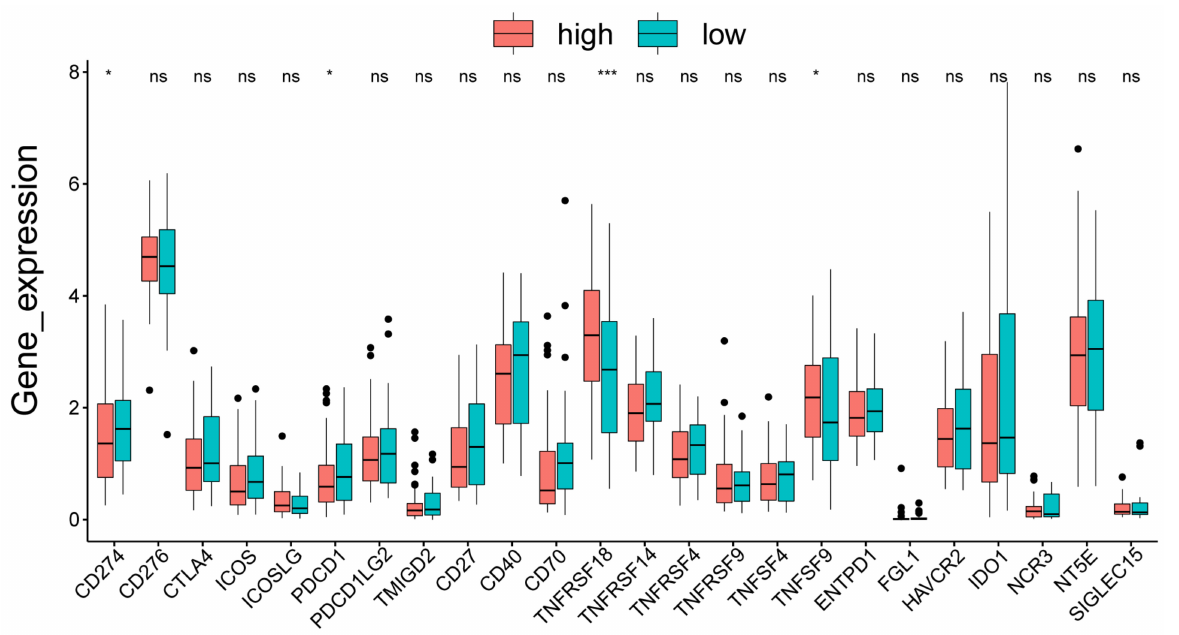
Figure 6. Analysis of immune check loci in high- and low-risk groups. * represents p < 0.05, *** represents p < 0.001, ns represents no significant